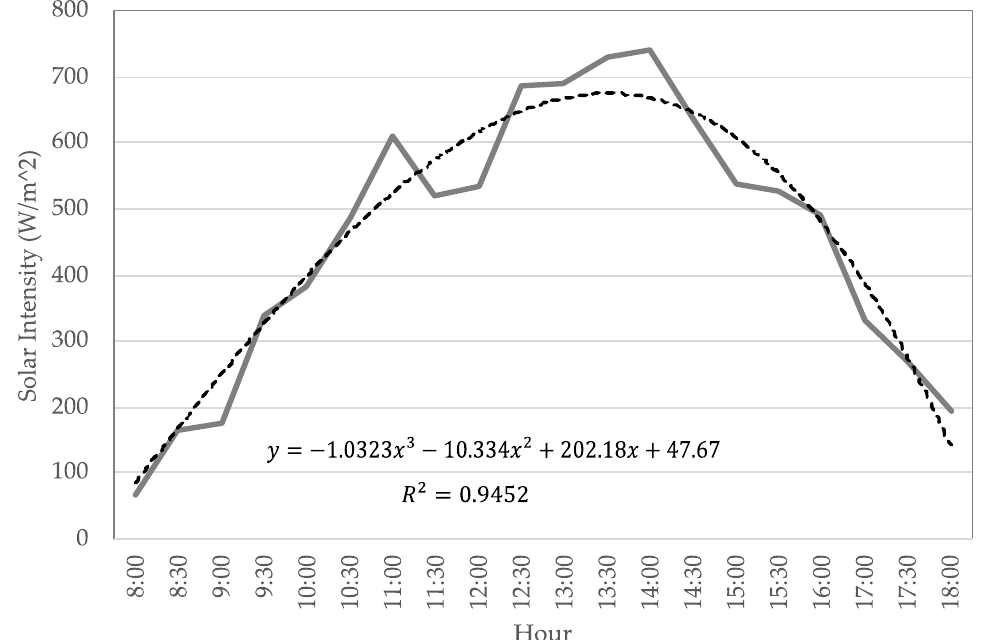
Figure 8. Average solar intensity during field trials. The continuous line represents the average experimental values of solar radiation, recorded every hour during the monitoring days. The dashed-dotted line represents the third-degree polynomial trend line of the experimental values, including the polynomial equation and its coefficient of determination R 2 .